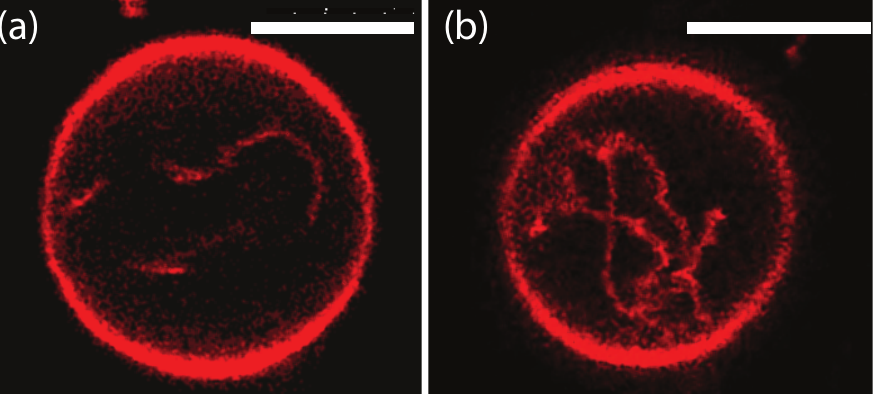
Figure 21. Membrane nanotubes protruding from the membranes of the mother vesicles (large red circles) into the vesicle interior in the absence of liquid–liquid phase separation. The vesicle membranes consist of the phospholipid POPC and the glycolipid GM1, with 2 mole% GM1 in ( a ) and 4 mole% GM1 in ( b ). The nanotubes are only visible when the membranes are doped with a fluorescently labeled lipid (red), in agreement with the theoretical analysis of micropipette experiments, which imply that the nanotubes have a width of the order of 100nm. Scale bars: 10 µ m